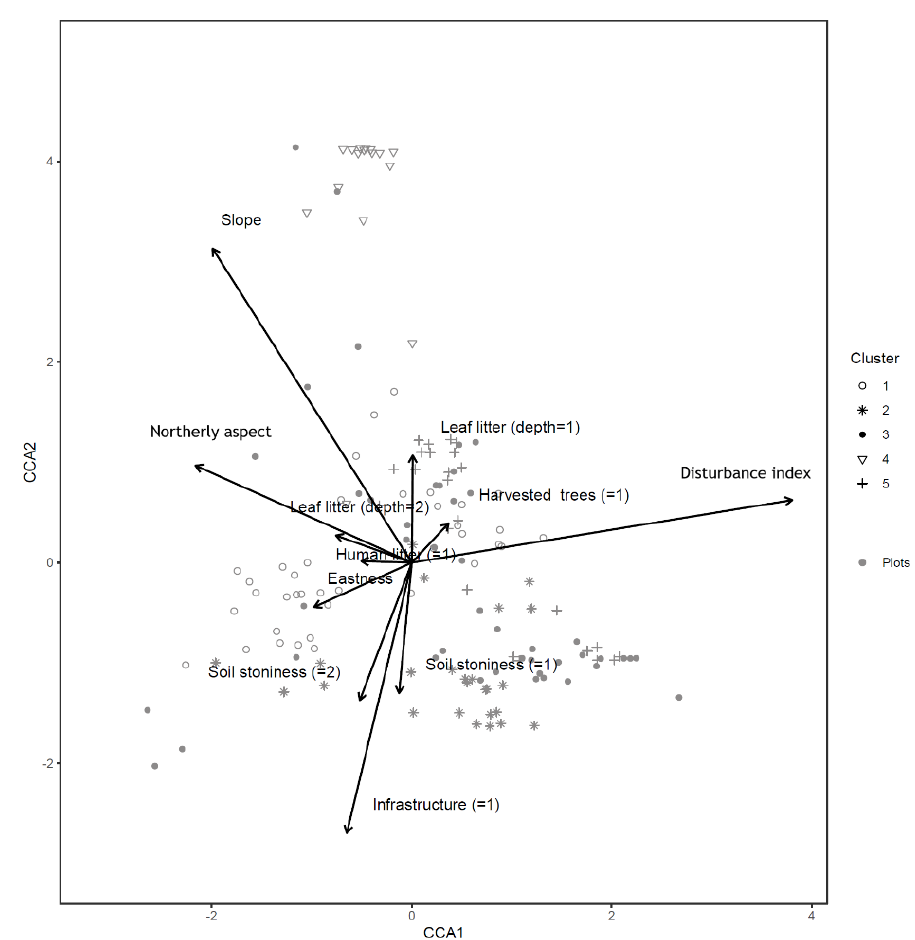
Figure B1. Canonical correspondence analysis of 152 plots across six sacred forests for canopy trees. Plots are labeled according to the five clusters produced by the cluster analysis (1: pine ( Pinus nigra ); 2: mixed oaks (dominated by Quercus coccifera and Q. frainetto ); 3: sclerophyllous species ( Acer monspessulanum, Q. coccifera , and Juniperus oxycedrus ); 4: beech ( Fagus sylvatica ); 5: mixed broadleaves ( Q. pubescens and Carpinus orientalis ). Arrows indicate explanatory variables with their arrowheads indicating direction of